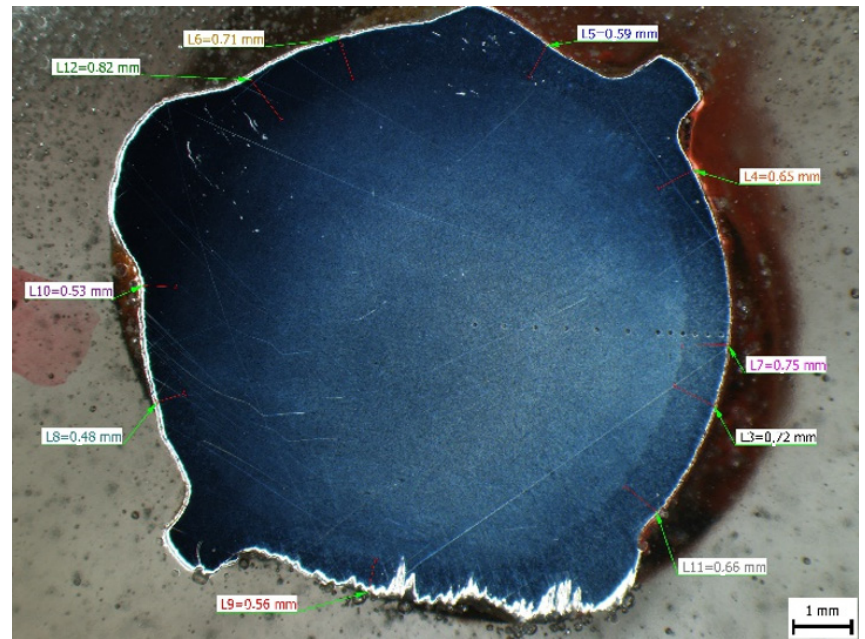
Figure 11. The cross-section of reinforcement ϕ 10 (B500 B).